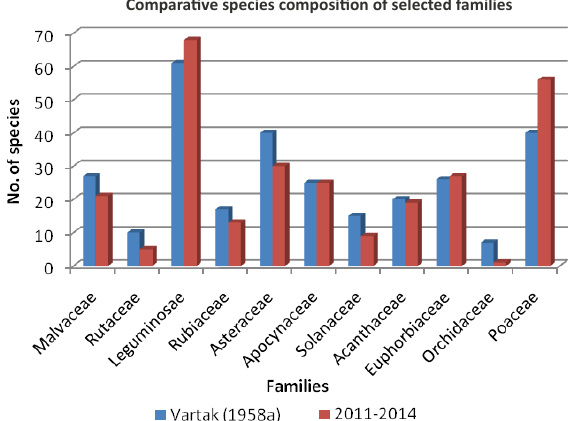
Figure 4. Comparitive analysis of selected families from the campus. Most dominant families have been selected for the